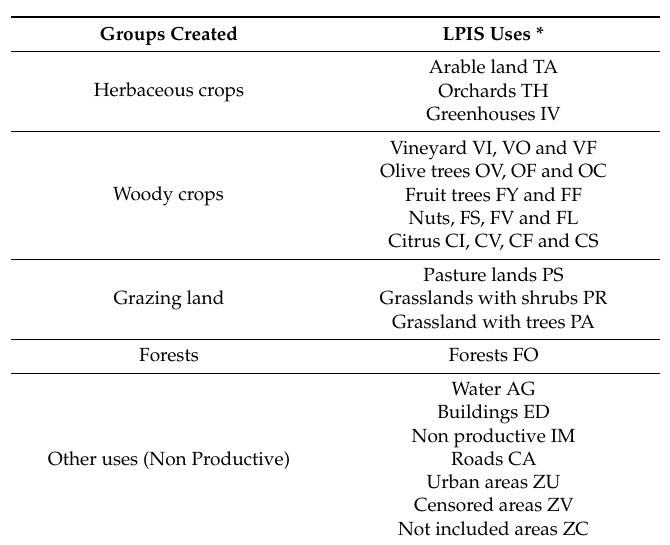
Table 1. Classification of land parcel identification system